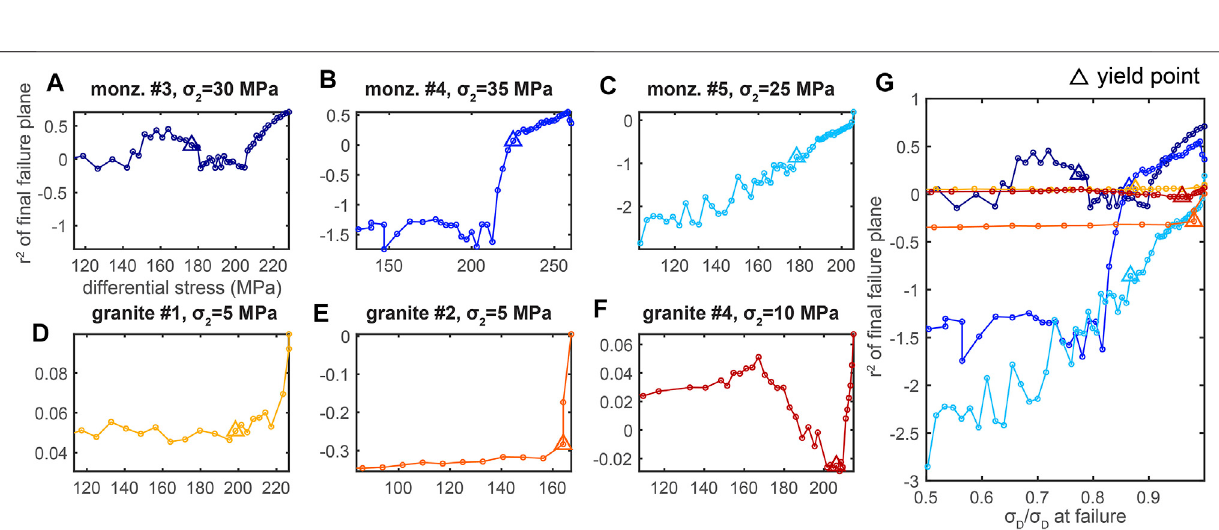
Frontiers in Earth Science |